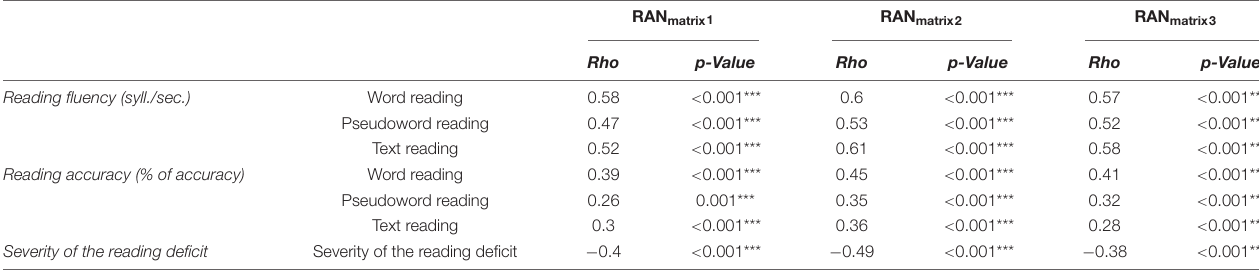
TABLE 6 | Matrix of non-parametric correlation between matrices of the RAN-Shapes and reading measures, and between matrices of the RAN-Shapes and the degree of severity of the reading deficit reported by monolingual Italian readers [monolingual Good Readers + monolingual Poor Readers; (mGR +